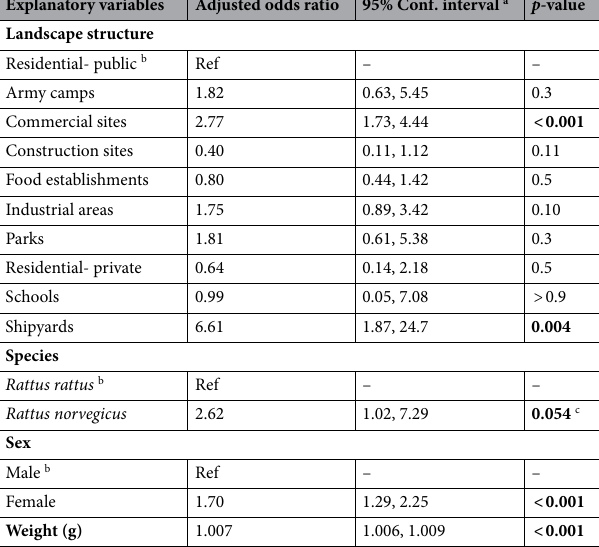
(Table 5). R. norvegicus had 2.62 times (AOR = 2.62, 95% CI: 1.02–7.29) higher likelihood of SEOV infection compared with R. rattus , but at a borderline statistical significance ( P = 0.054). SEOV infection was also inde- pendently associated with both the weight and sex of rodents. The prevalence of SEOV infection increases for every 1 g increase in body weight (AOR = 1.007, 95% CI: 1.006–1.009), whereas female rodents were 1.7 times (AOR = 1.70, 95% CI: 1.29–2.25) more likely than male rodents to be infected (Table 5). Rickettsia typhi .